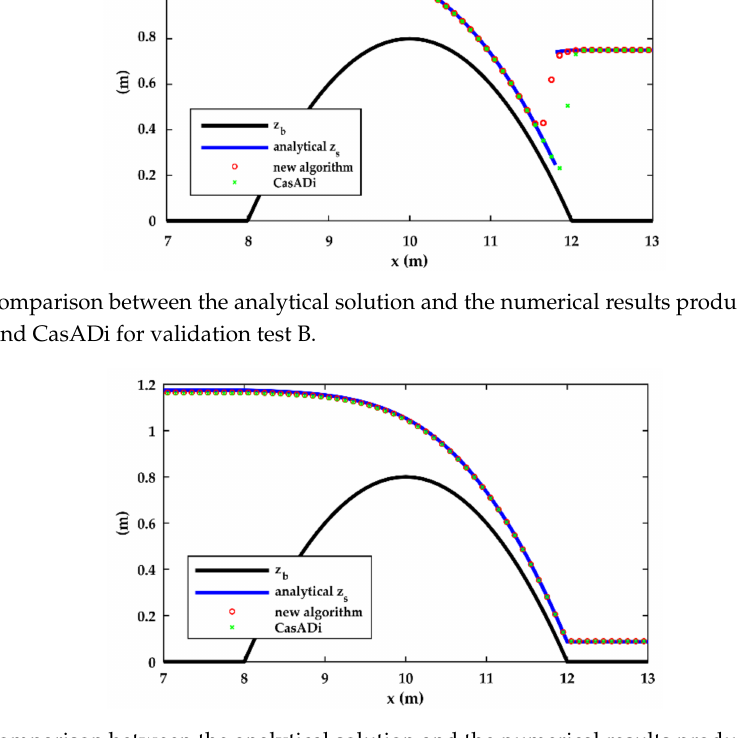
Figure 5. Comparison between the analytical solution and the numerical results produced by the new algorithm and CasADi for validation test